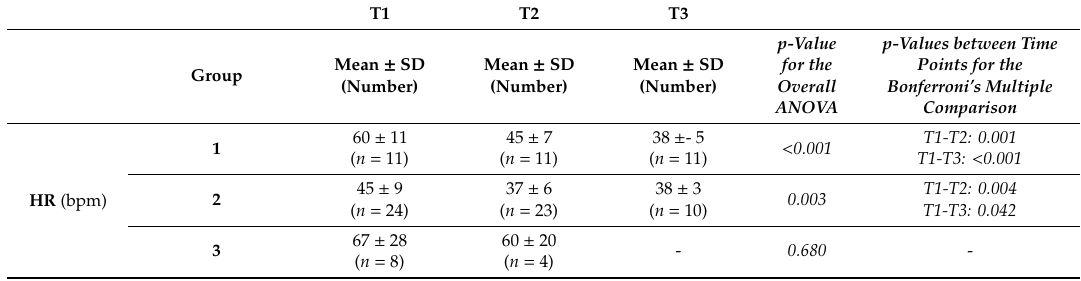
Table 2. Heart rate variability (HRV) parameters in the time domain analysis at the three measurement time points (T1, T2, and T3) and in the three treatment groups.